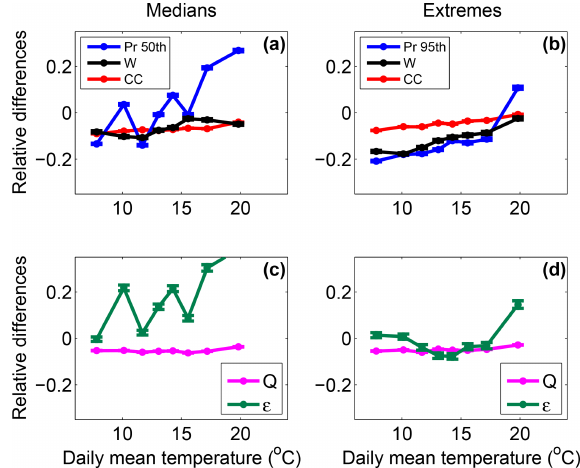
Figure 7. Relative differences between HR MAX and HR MIN simulations of total precipitation (blue) and vertical velocity (black, a, b ), precipitation efficiency (green, c, d ), and surface water vapour mixing ratio ( Q , magenta, c, d ) for median (a, c) and extreme (b, d) precipitation events as a function of the mean between the MIN and MAX daily mean temperature. The change expected accord- ing to the Clausius–Clapeyron law is displayed in red (a, b) . Error bars represent the 95% confidence interval of the precipitation per- centiles.